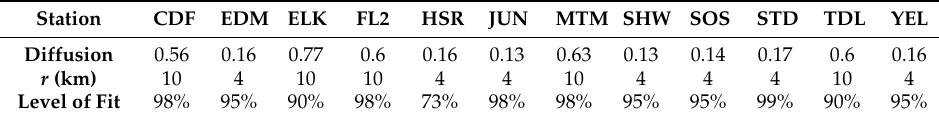
Table 2. Comparison of fit of observed data with simplified theoretical data at 9 Hz.